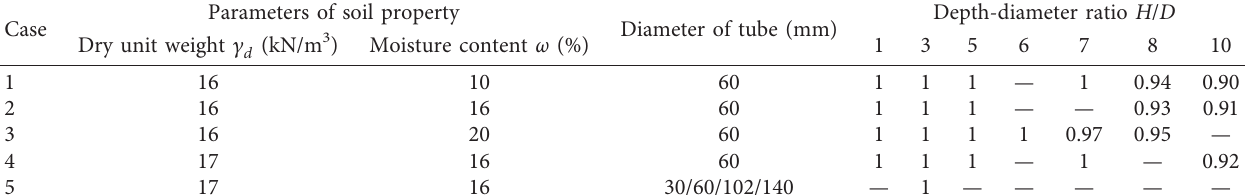
Table 3: Correction factor of test results.